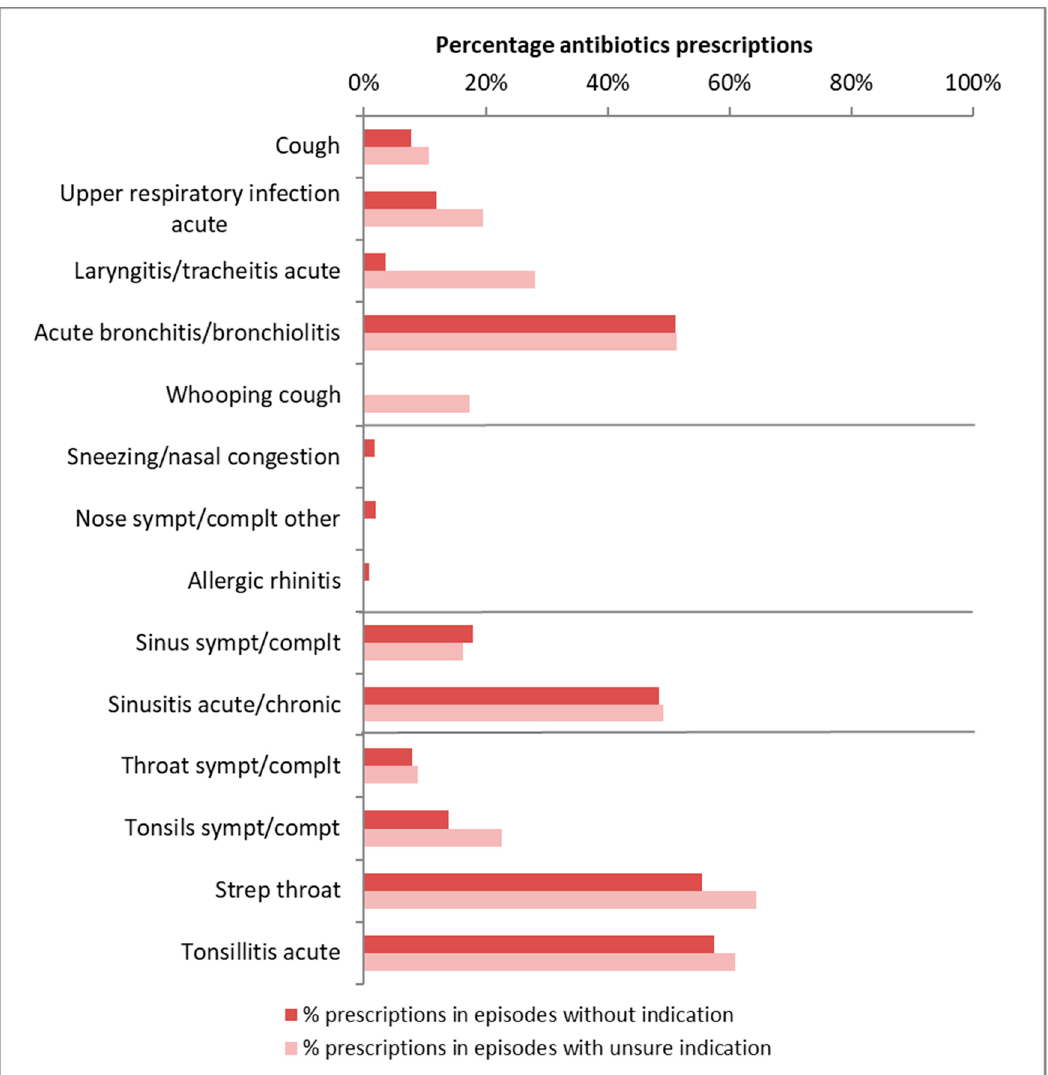
Figure 1. Percentage antibiotics prescription per RTI with unsure and without antibiotic indication.